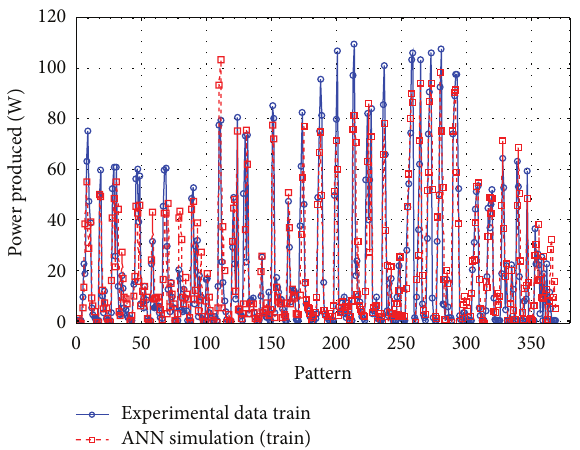
Figure 14: Power produced from experimental results and from prediction ANN analysis on data